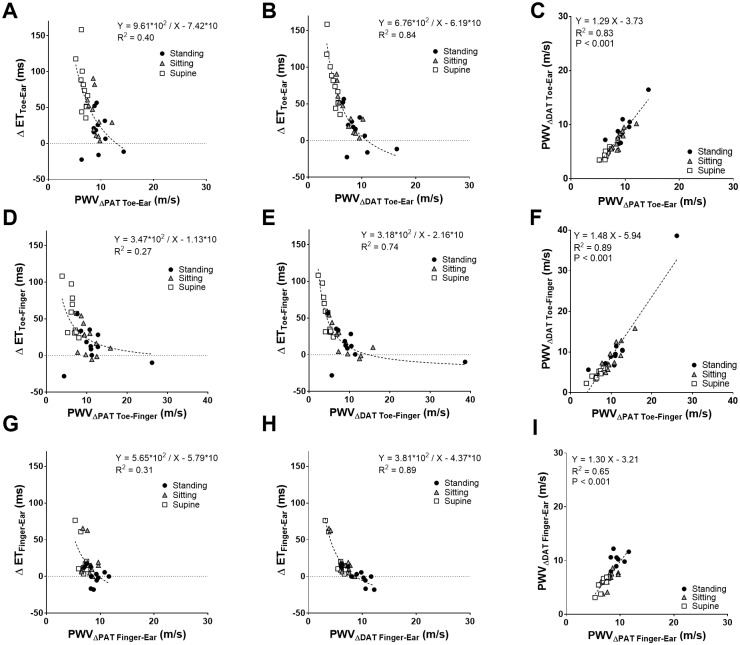
Relationship between ΔET, PWVΔPAT, and PWVΔDAT.The relationship between ΔET and PWVΔPAT (A, D, G), between ΔET and PWVΔDAT (B, E, H), between PWVΔDAT and PWVΔPAT (C, F, I) for each pair of locations (Toe-Ear: A, B, C; Toe-Finger: D, E, F; Finger-Ear: G, H, I). Each individual subject has three dots on each graph which indicate mean values derived from the standing (black circle), sitting (gray triangle) and supine (white square) positions. The dashed line indicates the hyperbolic or linear regression line. The regression equation and the coefficient of determination (R2) are presented in each graph. ET: ejection time; PWV: pulse wave velocity; PAT: pulse arrival time; DAT: dicrotic notch arrival time.